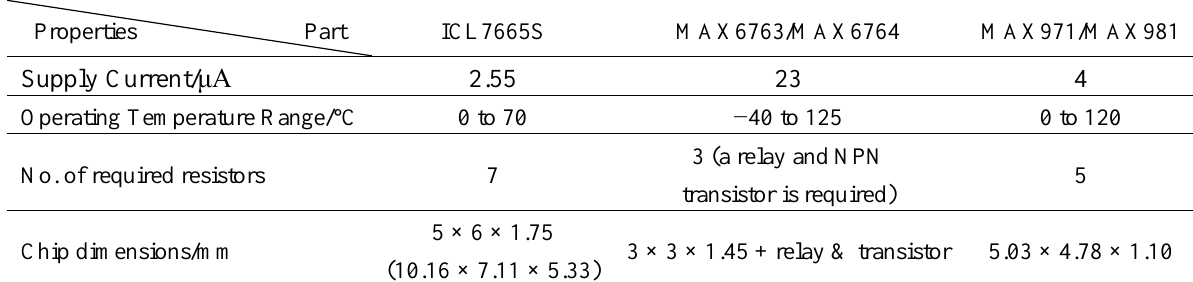
Table 6. A comparison between three selected comparators.